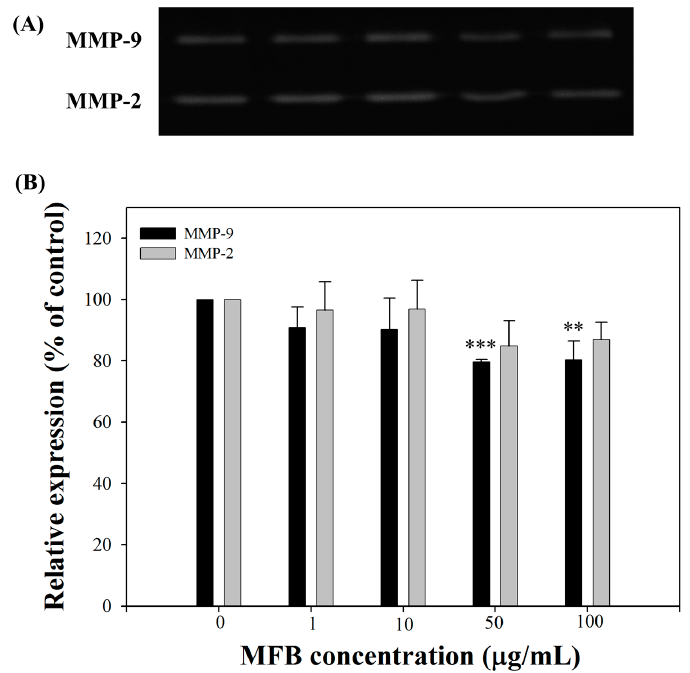
Figure 6. Effects of MFB on MMP-2 and MMP-9 activity in SK-Hep-1 cells. Cells (5 × 10 4 ) were incubated with MFB for 24 h. ( A ) Zymography of MMP-2 and MMP-9; ( B ) Densitometric analysis of ( A ). Values are means ± SD, n = 3; significant difference from control value was indicated ** p < 0.01, and *** p < 0.001.